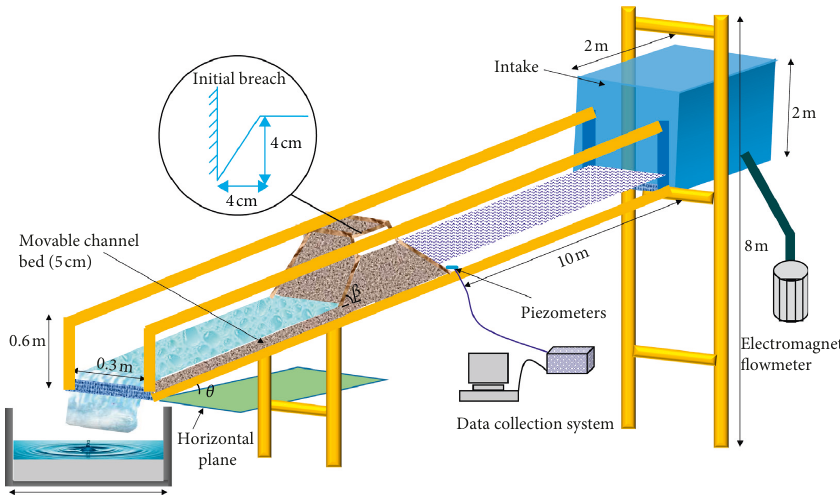
Figure 3: A sketch of the flume and its hydrological equipment. It shows the full size and shape of the dam and the size of the initial